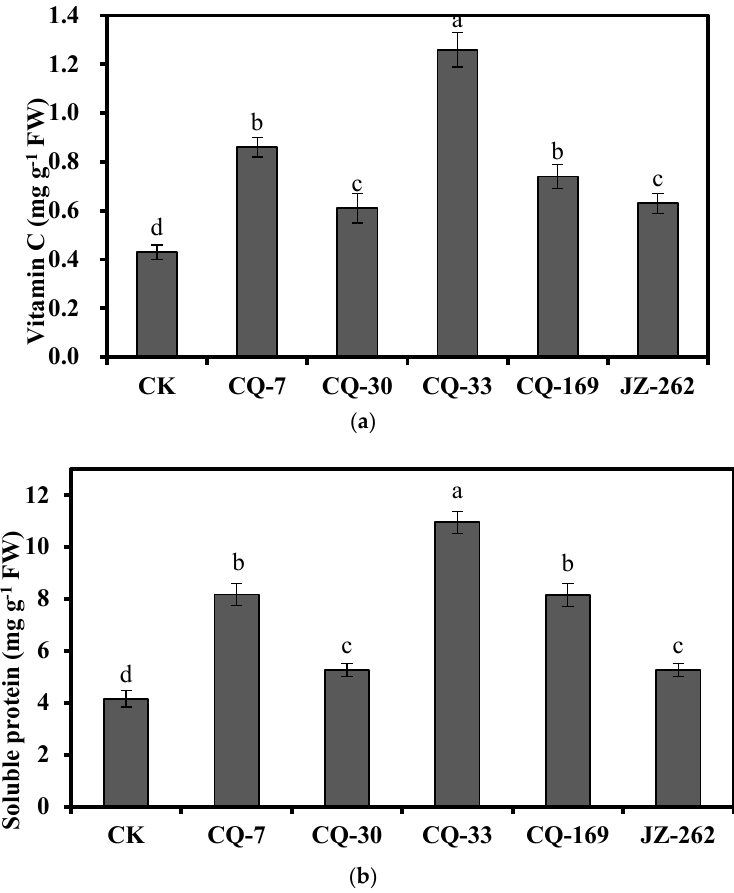
Figure 6. Effects of strains on the contents of solution protein and vitamin C in shoots of the water spinach grown in the 5 mg L − 1 Cd 2+ and 20 mg L − 1 Pb 2+ contaminated solution (x ± s). a : Vitamin C content; b : Soluble protein content. Error bars are ± standard error ( n = 3). Values followed by different lowercase letters ( a – d ) significantly at the p < 0.05 level (Tukey’s test). FW: fresh weight.